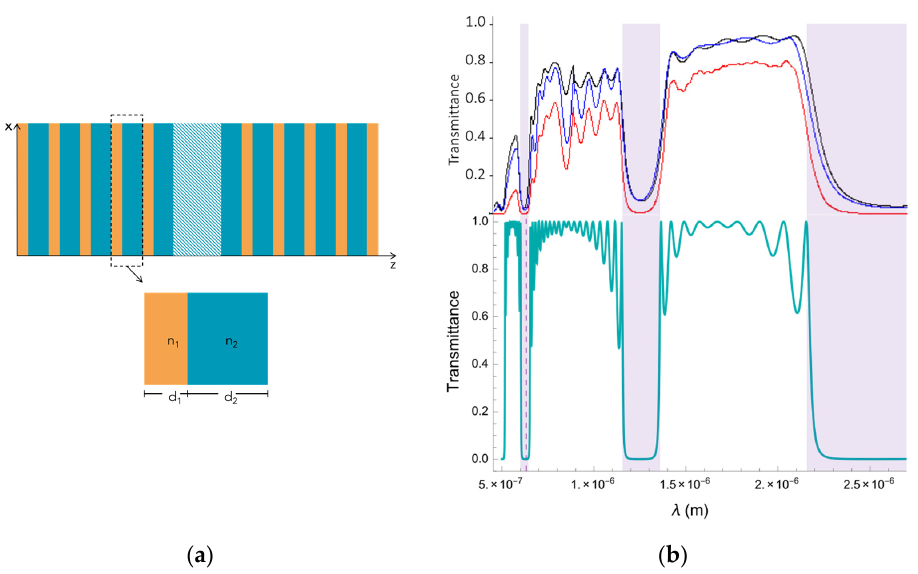
Figure 1. ( a ) Photonic device used in the experiment. Yellow and blue layers represent the Psi multilayer, while light blue layer is the air defect in the middle of the structure. ( b ) The measured transmittance of the complete multilayered device of porous silicon (top) has been compared with the theoretical model (bottom). The band gaps coincide in all cases, specifically in the selected working region (around 633 nm), for the refractive index of n 1 = 1.1 and n 2 = 2 and thicknesses of d 1 = 335 nm and d 2 = 438 nm. The transmittance line of the multilayer used in the experiment is the black line.